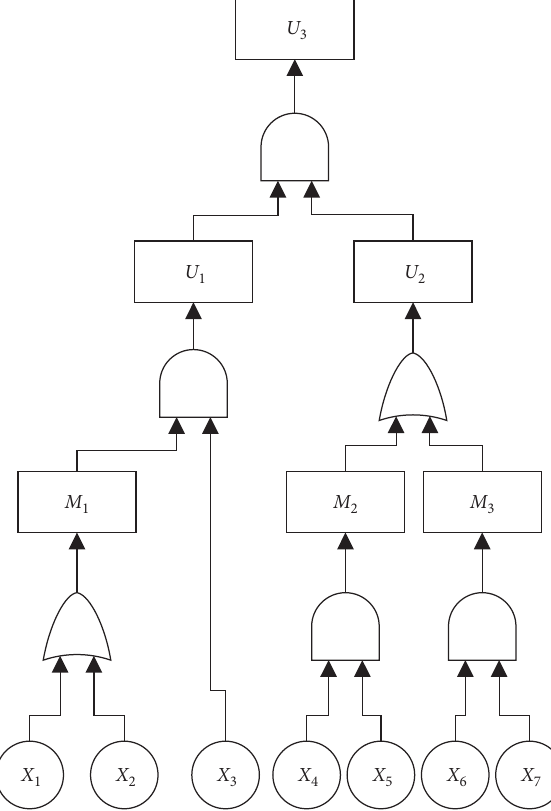
Figure 1: The graphical fault tree analysis